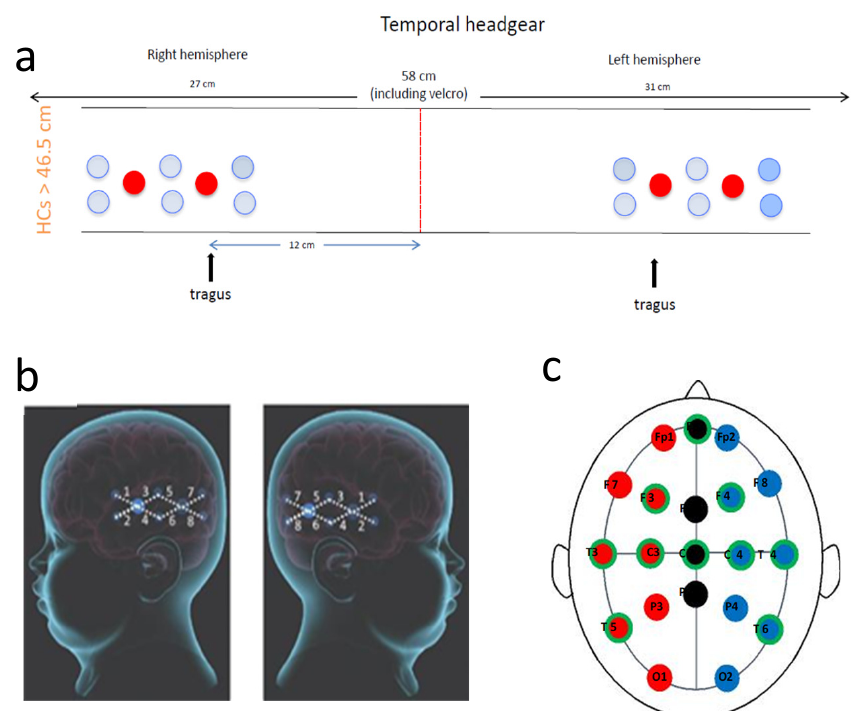
Figure 6. Recording setup. ( a ): Schematic presentation of the bNIRS headband used. Eight channels were placed over each temporal lobe. The red line shows centre front. The front light source was placed over the tragus on both sides; ( b ): Diagram showing bNIRS channel locations across the left and right temporal lobes (large blue circles are the sources and the smaller one are the detectors with 25 mm source-detector distance); and ( c ): Diagram showing EEG electrode locations with the electrode positions used in this study circled in green.